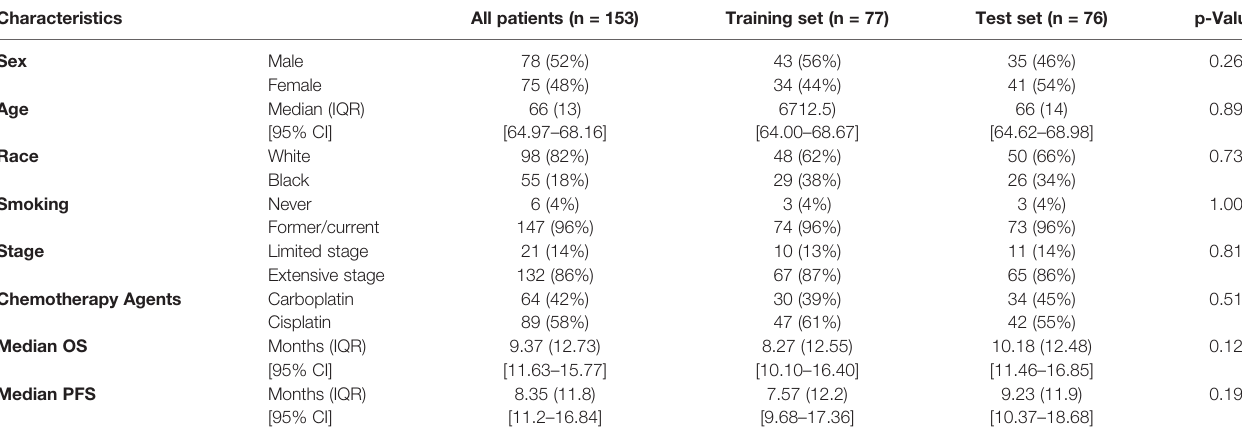
TABLE 2 | Demographics and clinical characteristics for patients, categorized by training and test sets.